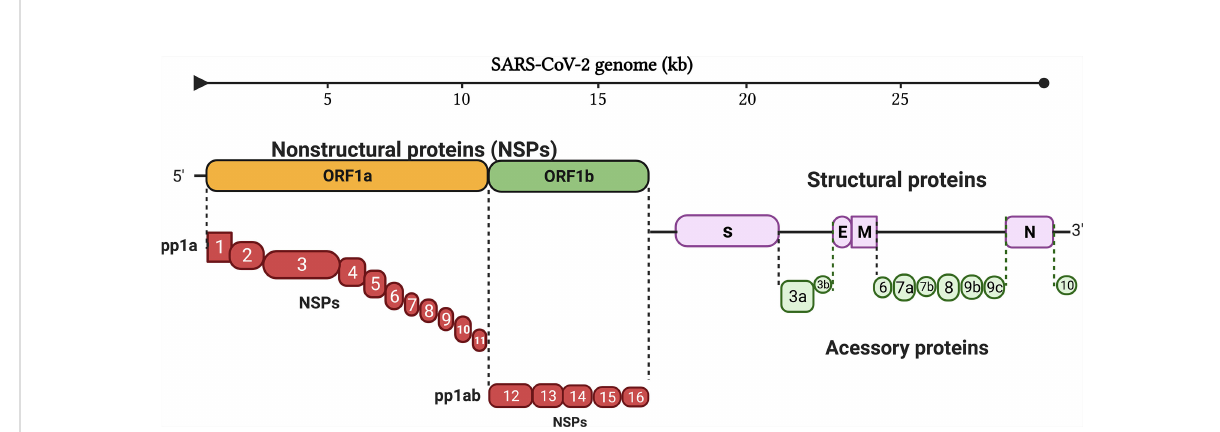
FIGURE 1 Genome organization of SARS-CoV-2. The genome of SARS-CoV-2 consists of 16 non-structural proteins, ranging from NSP1 to NSP16, four structural proteins (S, E, M and N), and interspersed between these structural proteins are nine accessory proteins. (S, Spike protein; E, Envelop protein; M, Membrane protein; N, Nucleocapsid